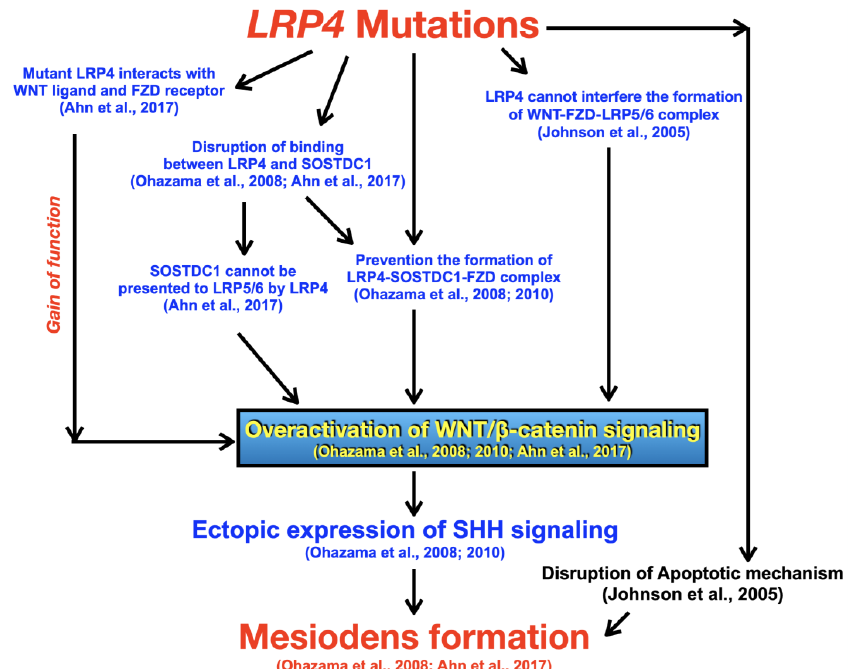
Figure 7. Hypothetical flowchart of pathogenetic pathways for mesiodens formation as a result of LRP4 variants. When the mutant Lrp4 does not properly interact with Sostdc1 as a result of mutation, it upregulates Wnt/β -catenin signaling by forming the Wnt-Fzd-Lrp4 complex. The resulting increase in WNT/β -catenin signaling and/or broadening of the placodal regions is responsible for the subsequent formation of the supernumerary teeth. Overactivation of WNT/ β -catenin signaling leading to ectopic expression of SHH signaling is the key to mesiodens formation